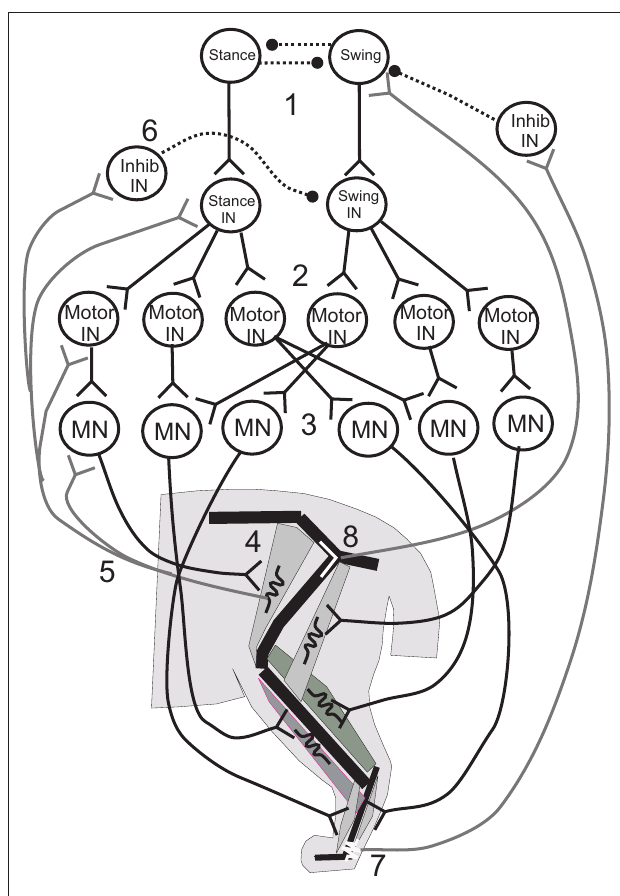
Figure 3 | illustrative diagram of the neuromechanical system of the cat hind leg; details differ from those presented in the four papers reviewed. 1. Swing/stance CPG. 2. Stance and Swing INs excite Motor INs. 3. Motor INs excite overlapping pools of Motor Neurons. 4. Motor Neurons excite leg muscles. 5, 6. Muscle spindle Ia and II afferents provide excitatory feedback to Motor Neurons, Motor INs, and Stance/Swing INs, and cross inhibition of antagonists. 7, 8. Ankle extensor afferents inhibit and hip extensor afferents excite Swing CPG elements to promote stance–swing